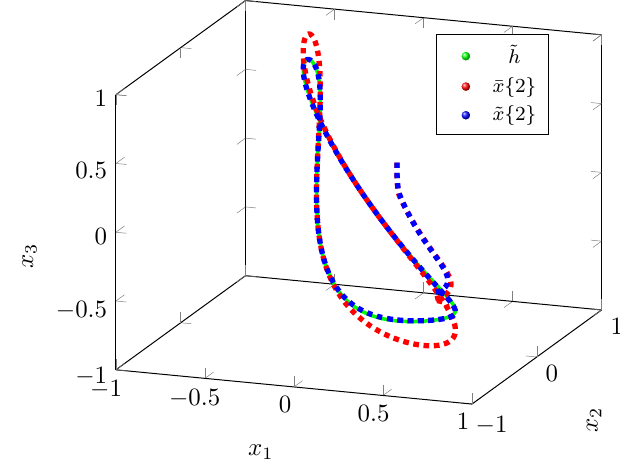
Figure 1. Phase portrait of quadcopter position.